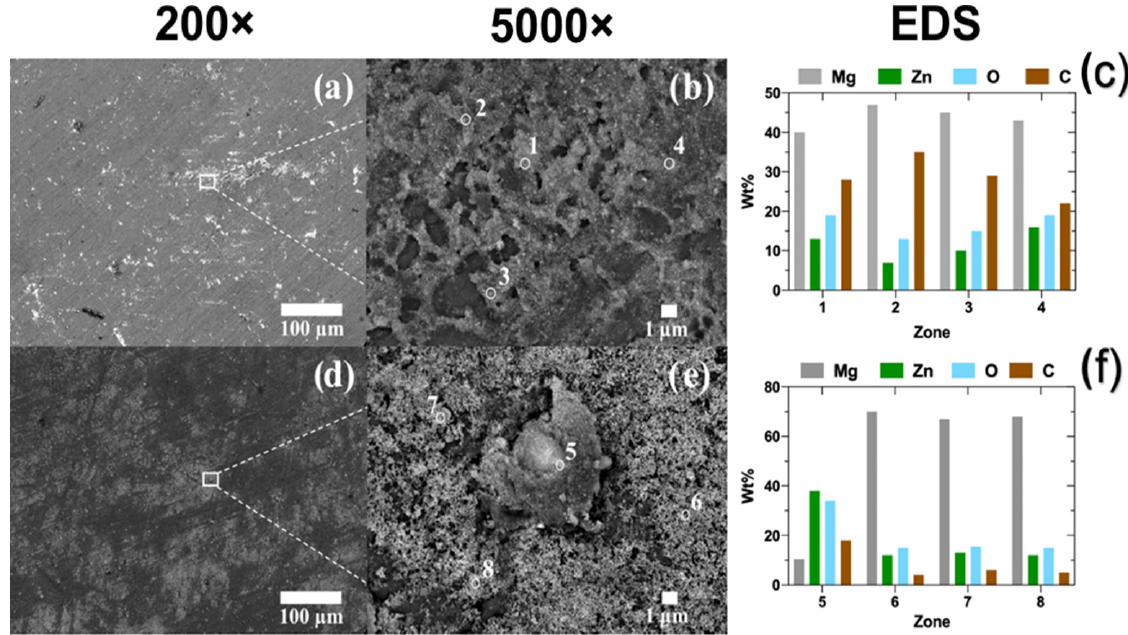
Figure 2. SEM images (200 × and 5000 × ) and EDS analysis of ZnO electroless deposits on the Mg– Ca0.3 surfaces, obtained from two 10 − 3 M aqueous solutions (at 21 °C): ( a – c ) ZnO and ( d – f ) Zn(NO 3 ) 2 .